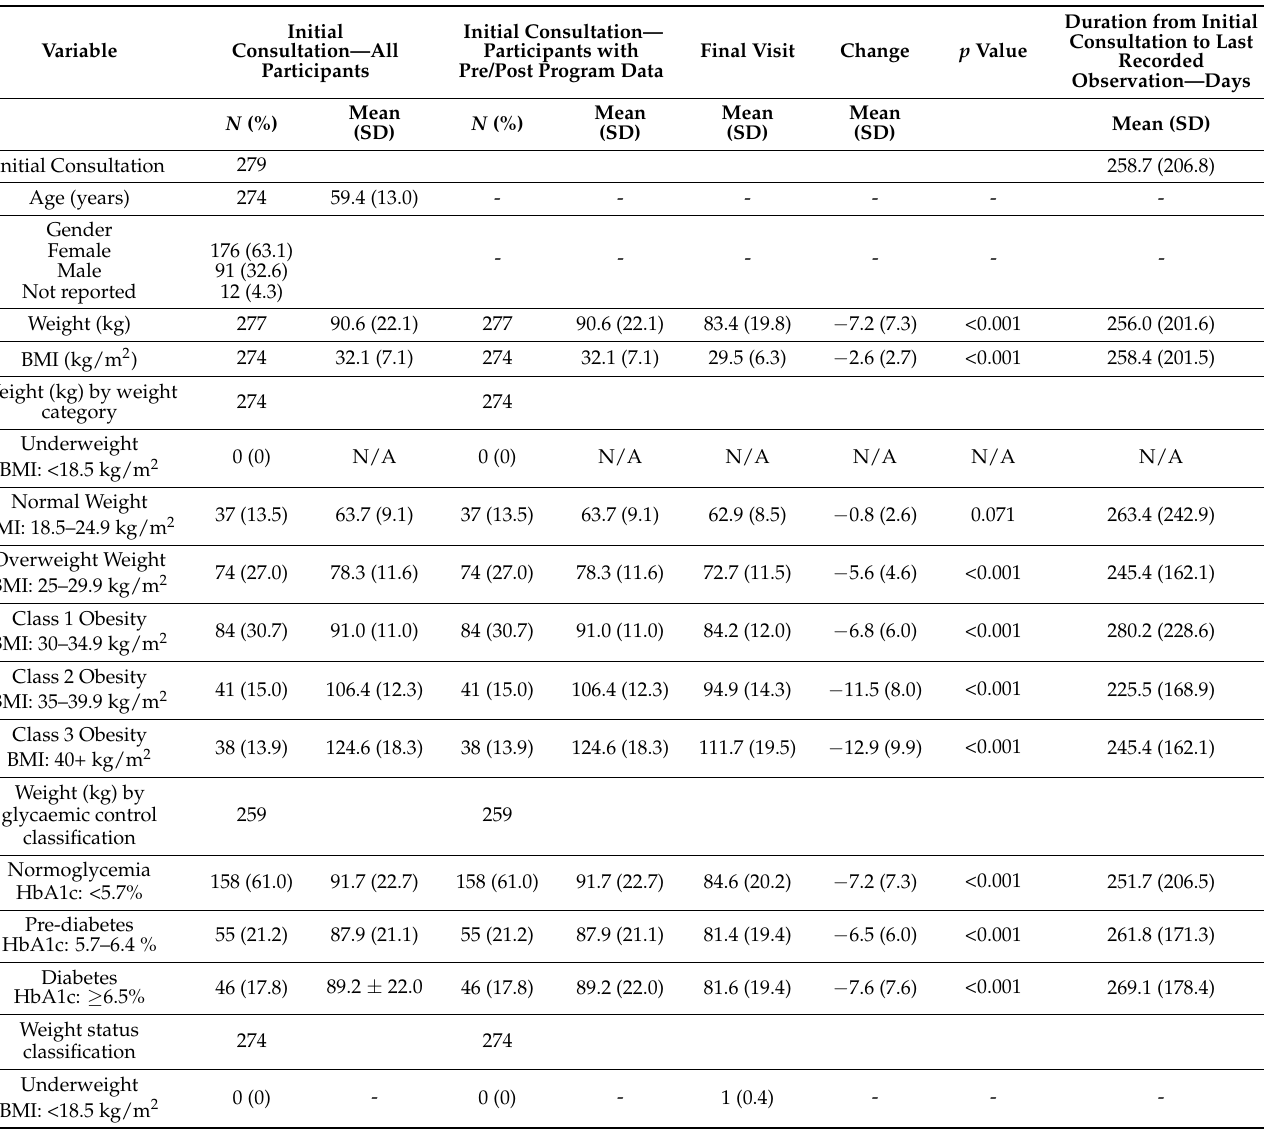
Table 3. Body weight, waist circumference, blood pressure and metabolic risk markers at commence- ment (initial consultation) and post program (final visit) of the Diversa Health program for members with reported biochemical